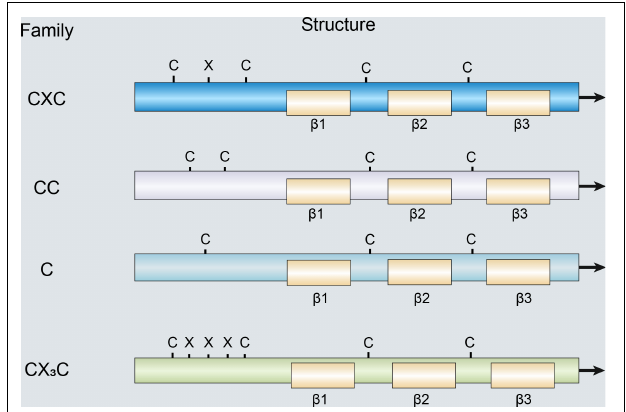
FIGURE 1 | Structure of members of the chemokine